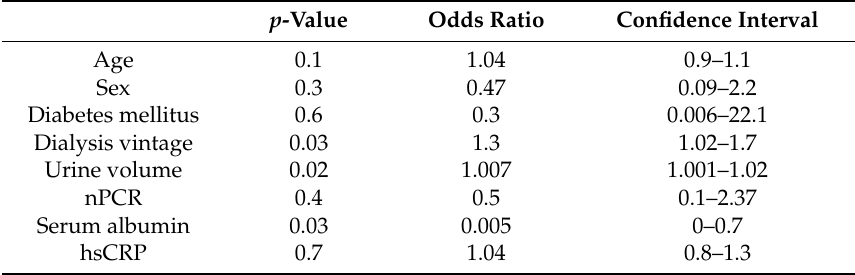
Table 4. Cox-regression analysis for the role of variables on serum bicarbonate concentrations less than 22